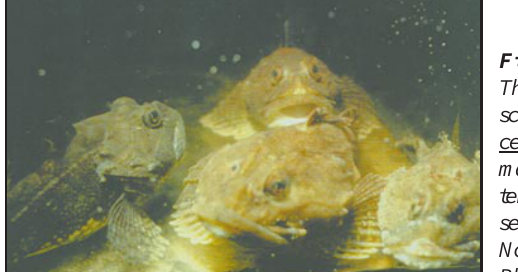
Fig. 1. The shorthorn sculpin (Myoxo